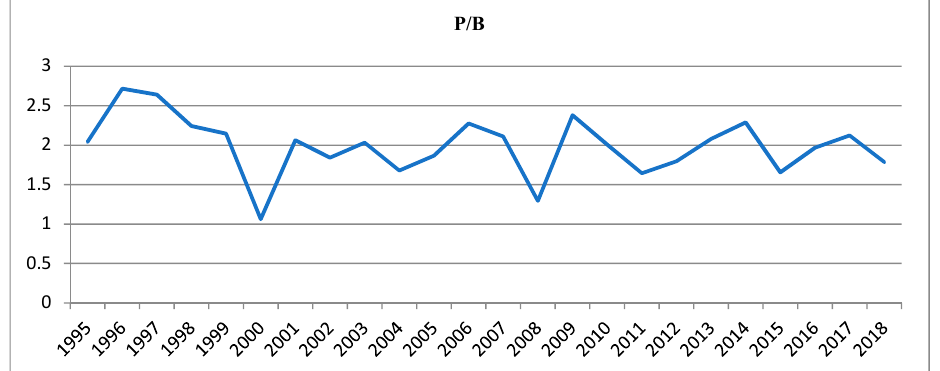
Figure 5. Fluctuations of average P/B over the years.